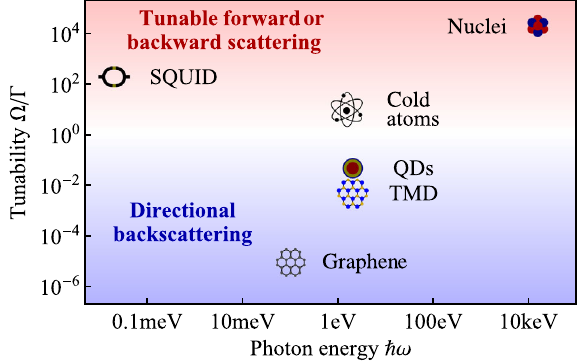
FIG. 8. Tunability of various resonant optomechanical systems operating in different spectral ranges. When Ω ≪ Γ (blue area), the directional scattering can occur only in the backward direction. When Ω ≫ Γ (red area), one can realize both direc- tional forward and backward scattering by a proper tuning of the incident light frequency and trembling frequency. Numerical parameters and references are given in Table I.